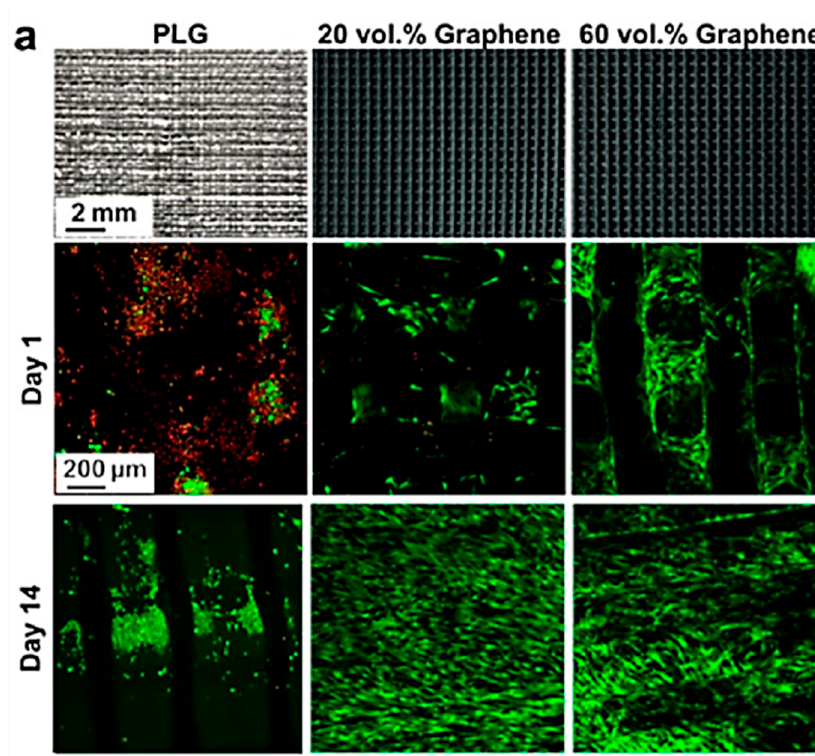
Figure 8. Photographs and cell viability (live cells in green and dead cells in red) of poly (lactic-co- glycolide) (PLG) scaffolds loaded with G manufactured by Direct Ink Writing (DIW). An increase in cell viability was produced when G was added (reprinted with permission from [268]. Copyright 2015 American Chemical Society).